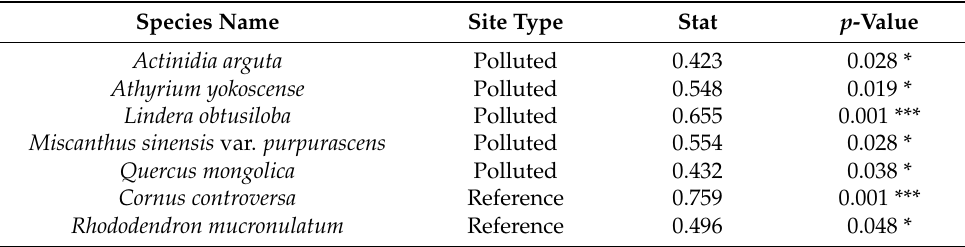
Table 4. The result of indicator species analysis for selecting the disappeared species and tolerant species to the polluted environment based on data collected in both polluted and natural valley forests. Pol-luted: tolerant species in the polluted site of valley forest; Reference: disappeared species in the natural reference site of valley